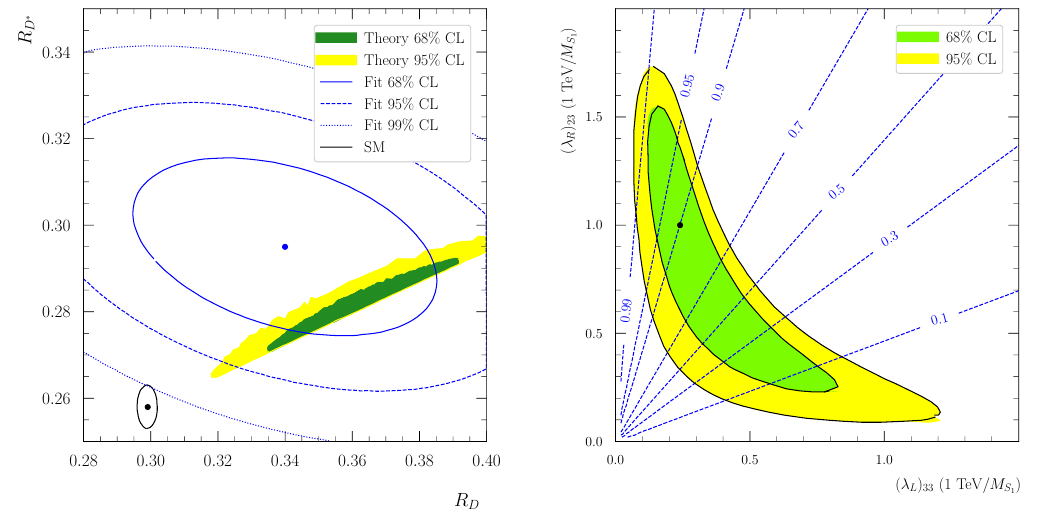
Figure 1 . Left : flavour fit to the charged current anomalies. The blue lines represent the current status in the measurements of the two R observables, compared with the SM predictions (gray D ( ∗ ) point and contour), using the Spring 2019 update from HFLAV [47]. The green and yellow dots correspond to the predicted values of R D – R D ∗ in our model. Our results are adapted from figure 1 (right) of [41]. Right : viable parameter space region as originating from the fit of flavour and precision observables as function of λ L,R /M S . Blue dashed lines are iso-lines of the branching 1 ratio BR( S 1 → c R τ R ) when setting y = 0 . The black dot represents the best-fit χ